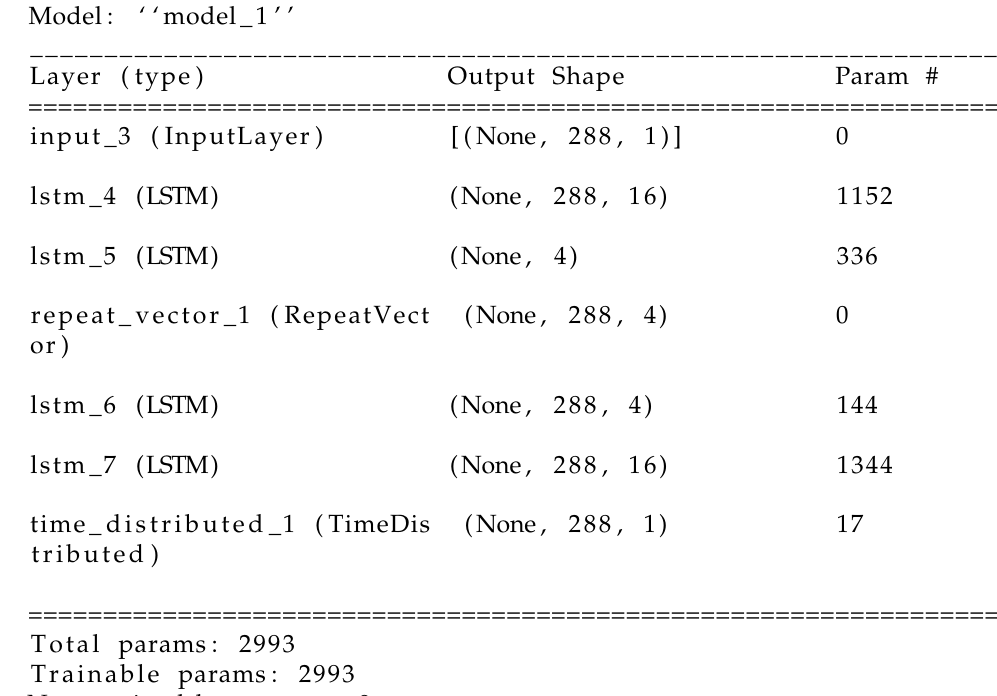
Figure 3. Specification for AE with LSTM-based